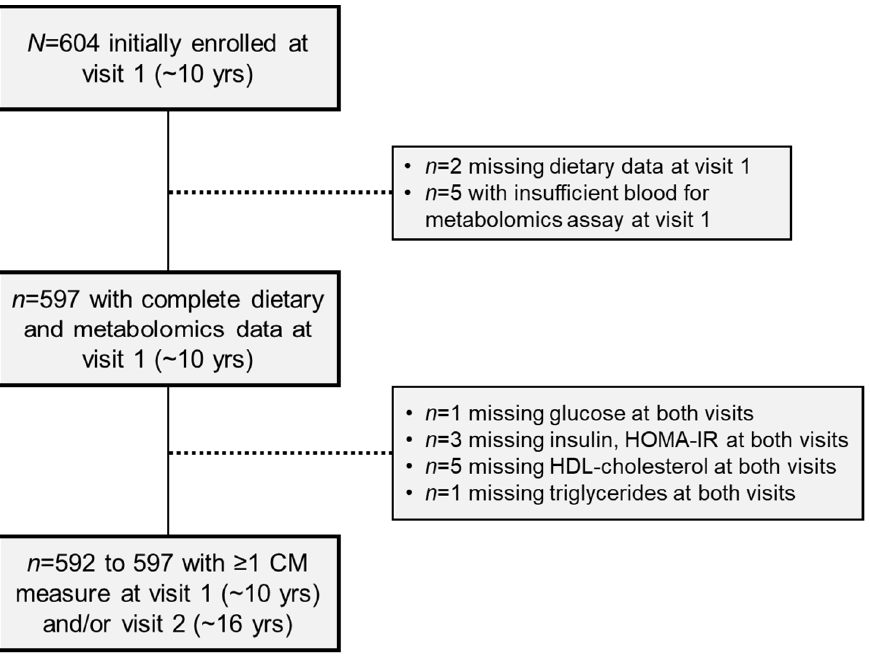
Figure 2. Selection of study participants from the Exploring Perinatal Outcomes among CHildren (EPOCH) Study. Abbreviations: CM, cardiometabolic; HOMA-IR, homeostatic model of assessment-insulin resistance; HDL, high-density lipoprotein.